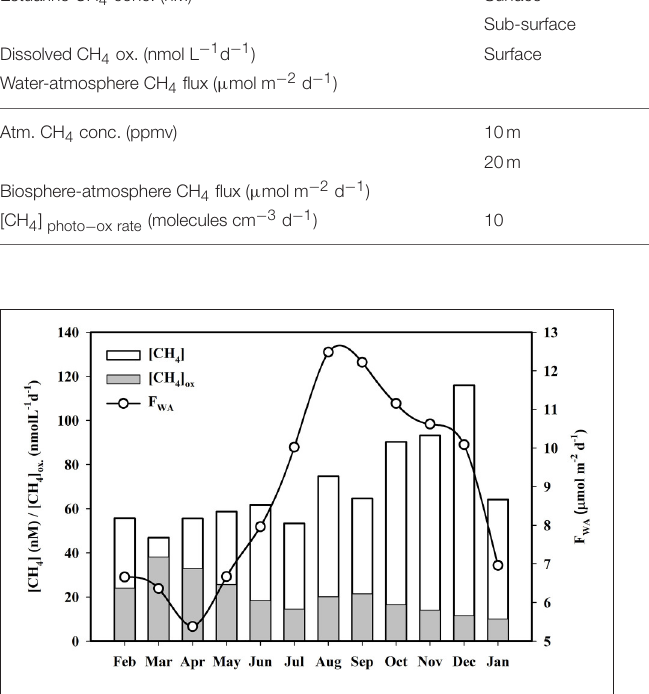
FIGURE 10 | Monthly variations of estuarine dissolved CH 4 conc., CH 4 oxidation, and air-water CH 4 exchange flux (F WA )